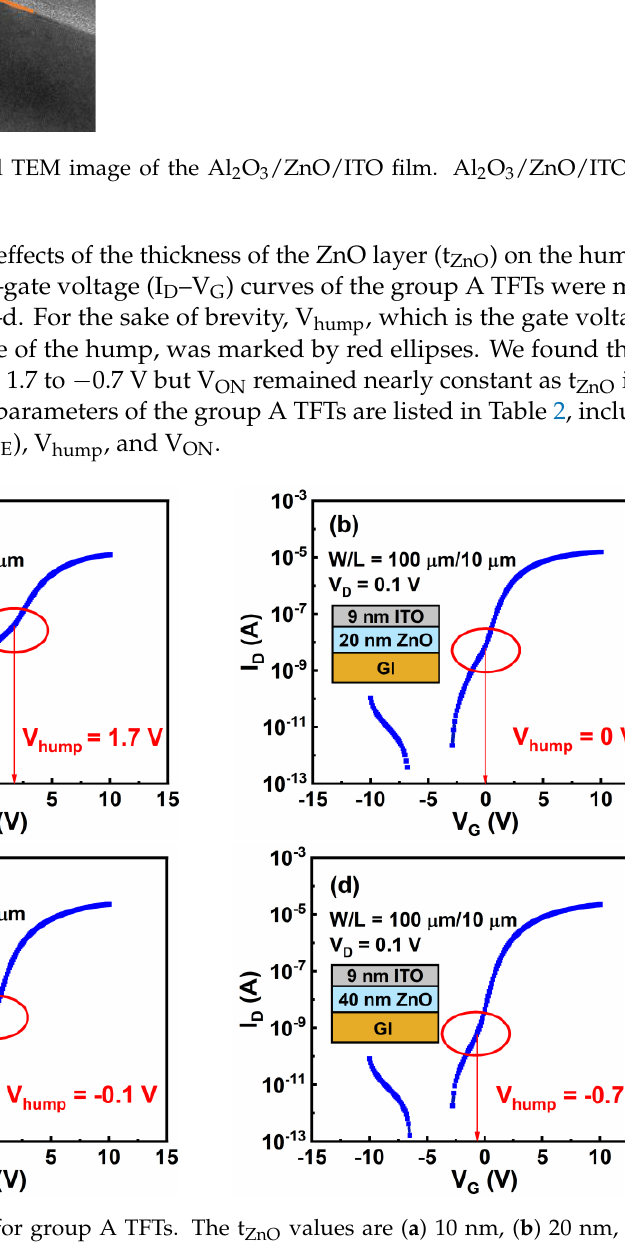
Figure 5. Cross-sectional TEM image of the Al 2 O 3 /ZnO/ITO film. Al 2 O 3 /ZnO/ITO film was deposited on Si substrate.